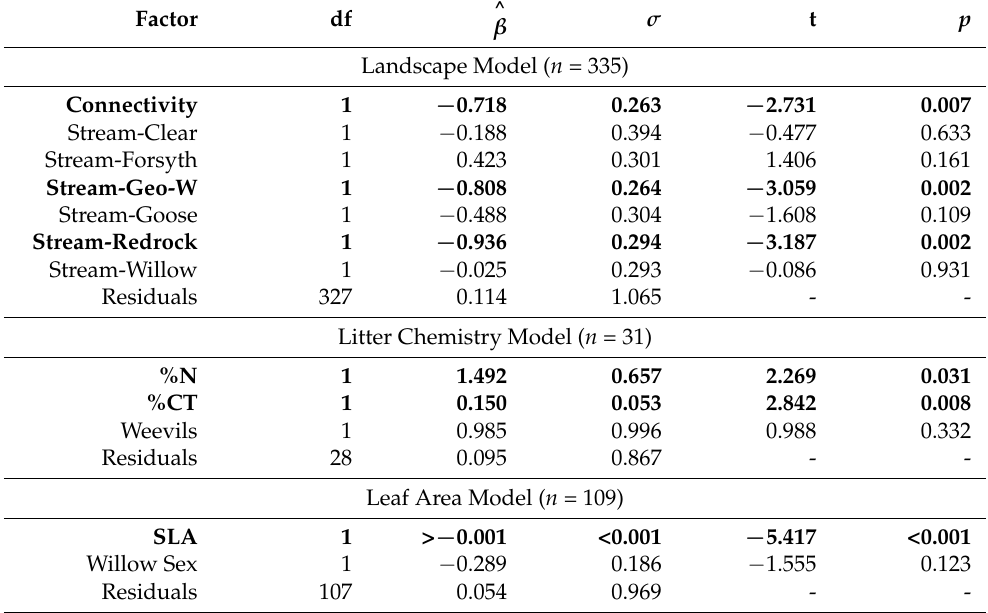
Table 1. Results of three generalized linear models for community richness as a response to changes in landscape, chemistry, and leaf area factors (AIC model selection in Table S2). Factors not present in this table were not part of the best model. Three separate models were used due to differences in the number of observations. The stream factor was categorical and thus tested against its respective first level. A pairwise estimated marginal means analysis can be found for the stream factor in Table S3. Bolded rows indicate significant effects at α = 0.05. Abbreviations: SLA is specific leaf area, df is degrees of freedom, ˆ β is the effect estimate, σ is the standard error of the effect estimate, t is the test statistic, and p is the null model probability